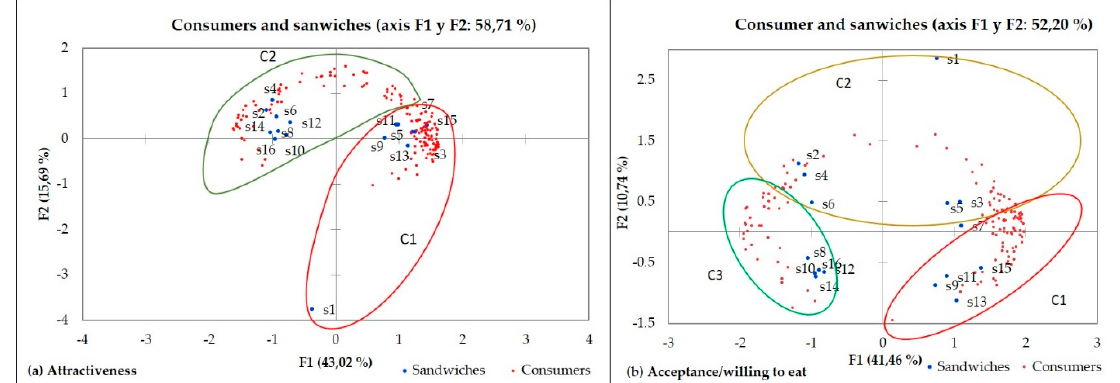
Figure 2. Clusters of respondents for ( a ) attractiveness; ( b ) acceptance.